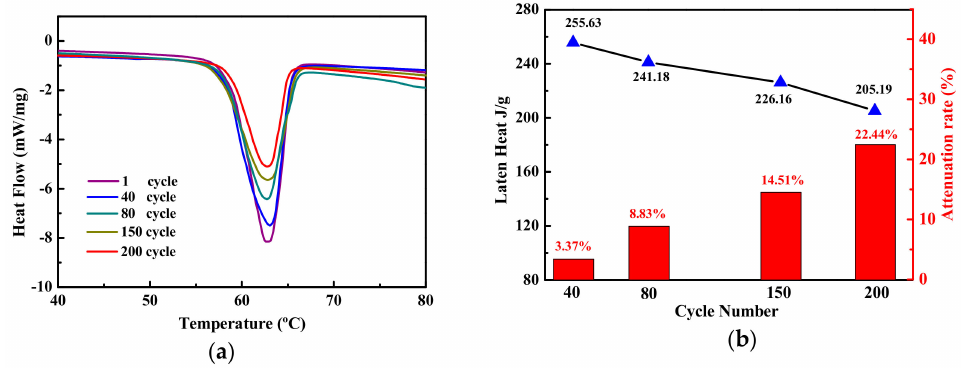
Figure 3. ( a ) DSC melting curves, ( b ) latent heat change curve and reduction extent of SAT / 5 wt.% DSP at di ff erent cycles.